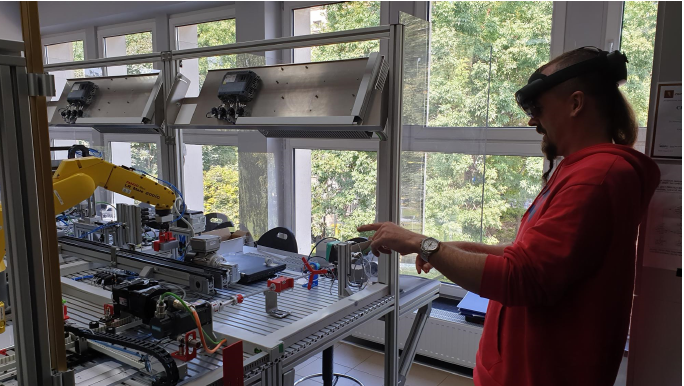
Figure 2. Microsoft Hololens MR goggles on the operator’s head.